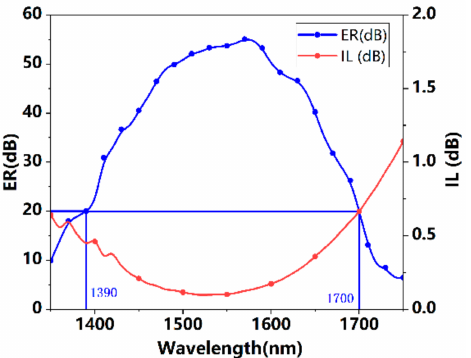
Figure 9. Wavelength dependent extinction ratio and insertion loss of the proposed polarizer evalu- ated under five grating sections.